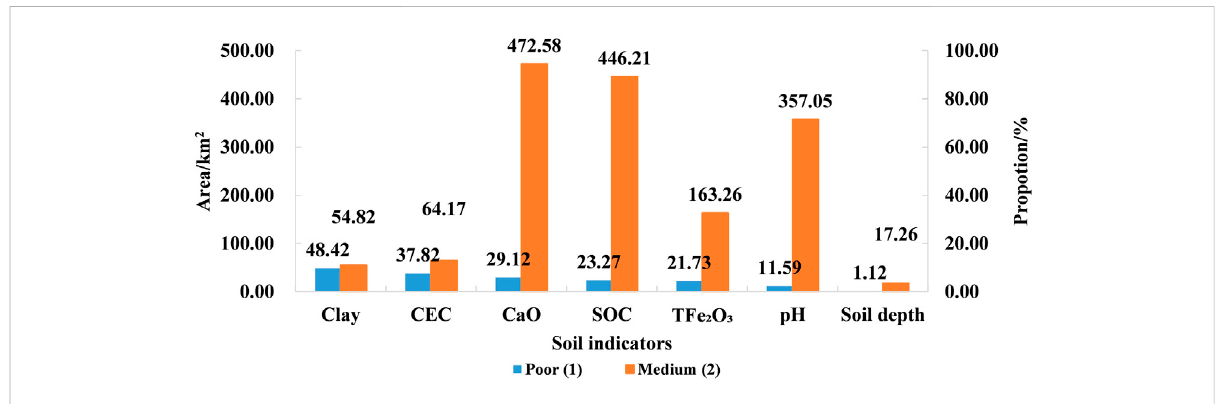
FIGURE 5 Limiting indicators for soil resilience in categories 1 and